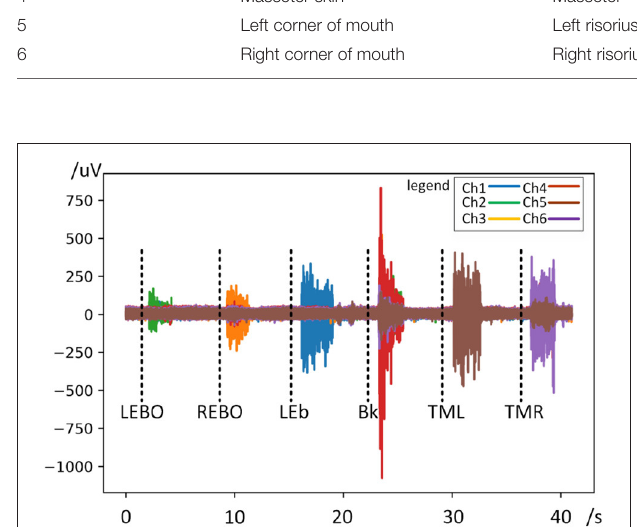
FIGURE 4 | Waveform diagram of a round in data acquisition. The black dotted lines indicate the action